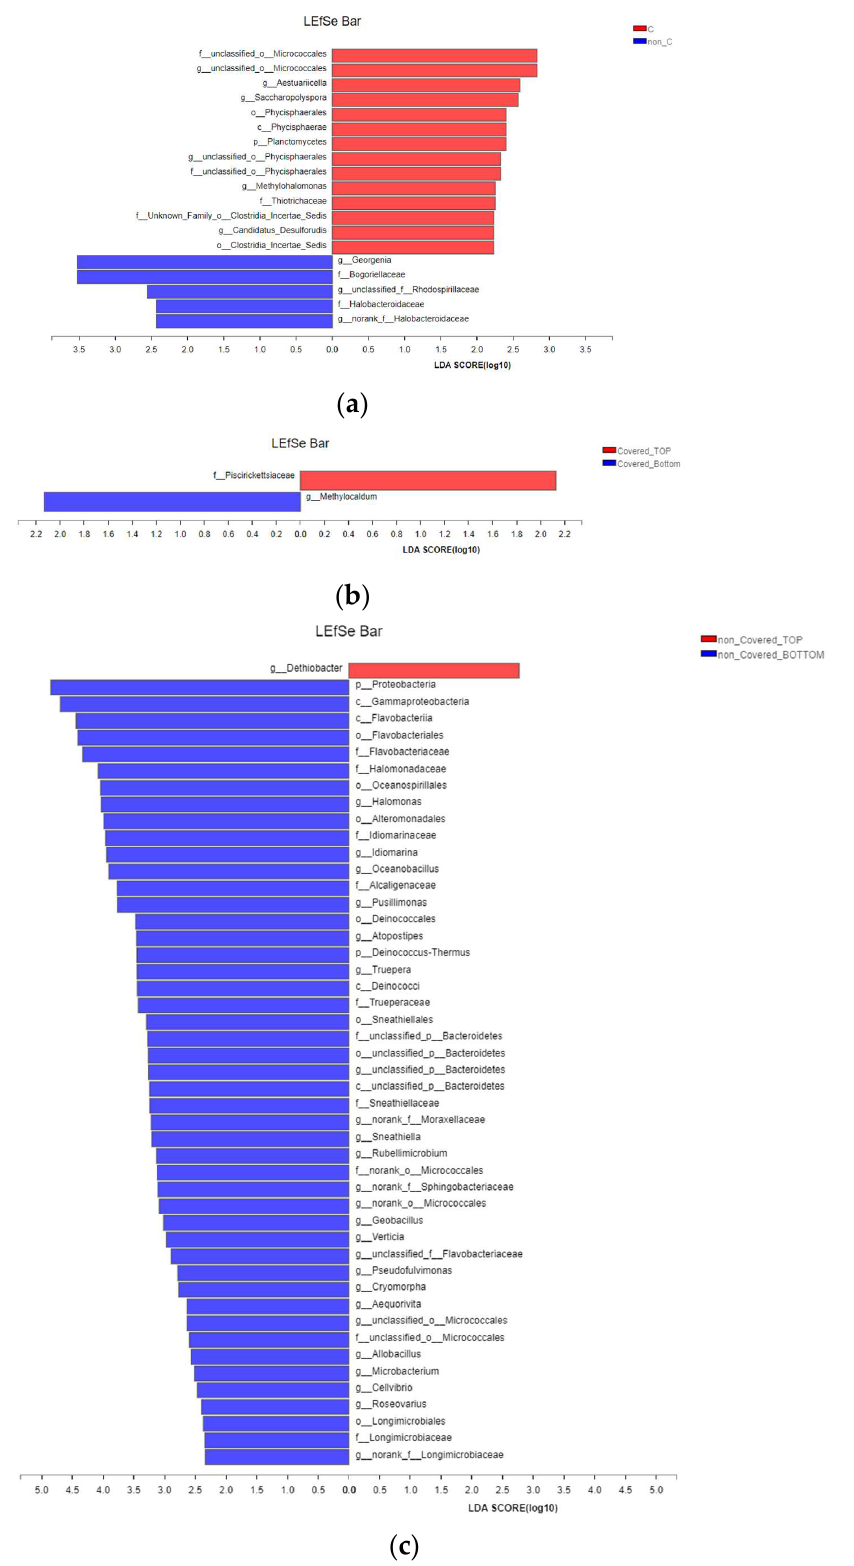
Figure 6. LEfSe multi-level species difference discriminant analysis between the covered and non-covered groups ( a ), between the top and bottom layers in the covered group ( b ) and between the top and bottom layers in the non-covered groups ( c ). The LDA discriminant histogram counts microbial groups that significantly affect multiple groups. The LDA score obtained by LDA analysis (linear regression analysis); the larger the LDA score, the greater the difference in species abundance.